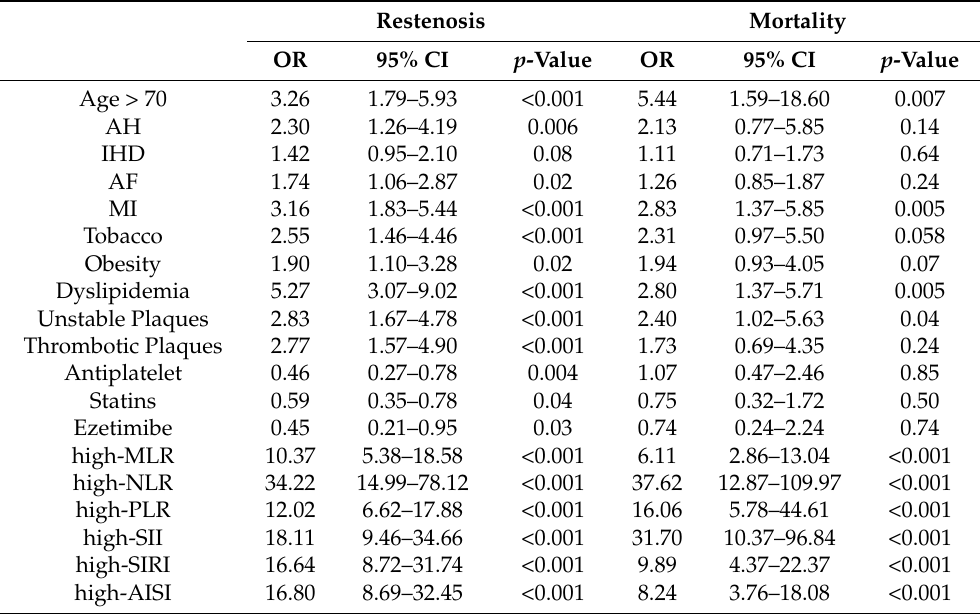
Table 4. Multivariate analysis for predictors of restenosis and mortality at 12 months following